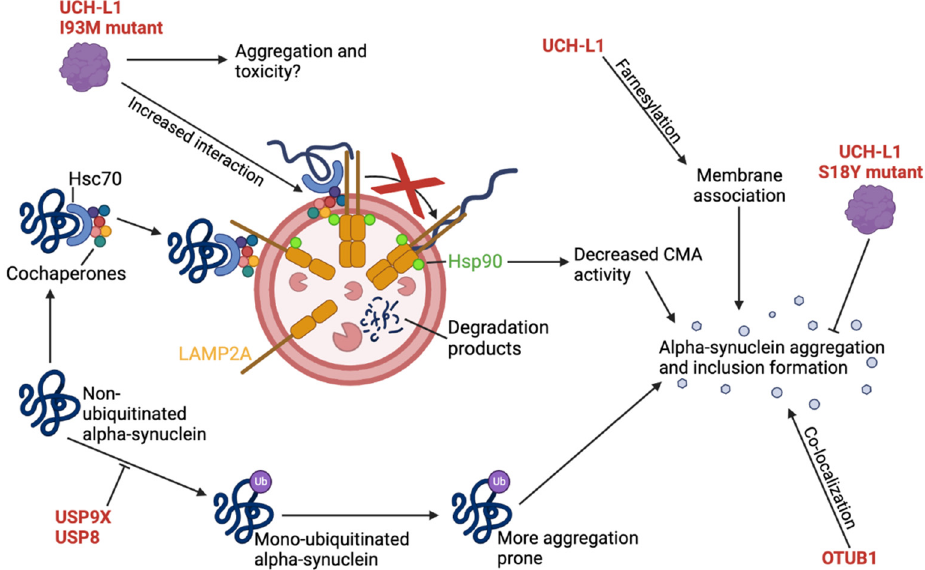
Figure 5. Visualization of how UCH-L1, USP9X, OTUB1, and USP8 affect the CMA and α -synuclein aggregation. The I93M UCH-L1 mutant is a more unfolded variant of the UCH-L1 protein, leading to possible increased aggregation and toxicity. More clearly, however, the mutation results in increased interaction with LAMP2A, Hsc70, and Hsp90, which inhibits the CMA machinery and leads to α -synuclein aggregation and the formation of inclusions. In contrast, the S18Y UCH-L1 mutant seems to exert protective effects against α -synuclein aggregation and inclusion formation. Sporadic PD patient midbrain sections have been shown to contain UCH-L1- and α -synuclein double-positive LBs. USP9X and USP8 inhibit the ubiquitination of α -synuclein, while USP9X deubiquitinates mono-ubiquitinated α -synuclein. The role of mono-ubiquitinated α -synuclein is unknown, but it is believed to be more aggregation ‐ prone and potentially results in the formation of α‐ synuclein ‐ positive LBs. In the case of USP9X, inhibition of the ubiquitination process directs the α‐ synuclein proteins towards the CMA and its degradation, thus conferring protective effects. OTUB1 has amyloidogenic effects and co ‐ localizes with α‐ synuclein. Lastly, USP8 deubiquitinates Lys63 ‐ linked chains, resulting in decreased clearance and potential aggregation of α‐ synuclein. Created using www.BioRender.com (accessed on 15 December 2022).